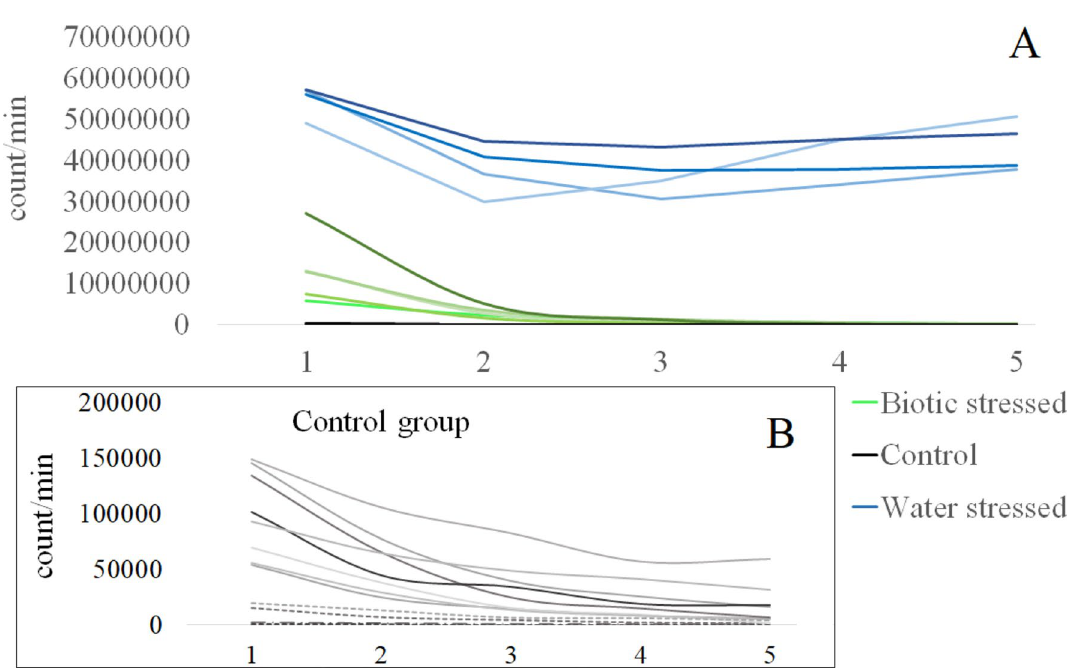
Figure 2. Some randomly selected examples of biophoton emission intensity change over time in different experimental groups (see detailed results later). ( A ) Blue lines refer to biophoton emission intensity of water- stressed plants, green refers to plants in the biotic-stressed group, black refers to measurements in the control group. ( B ) dynamics of biophoton emission intensity in the control group which is not visible in Fig. 1A due to the O (10 3 –10 4 ) difference in biophoton emission